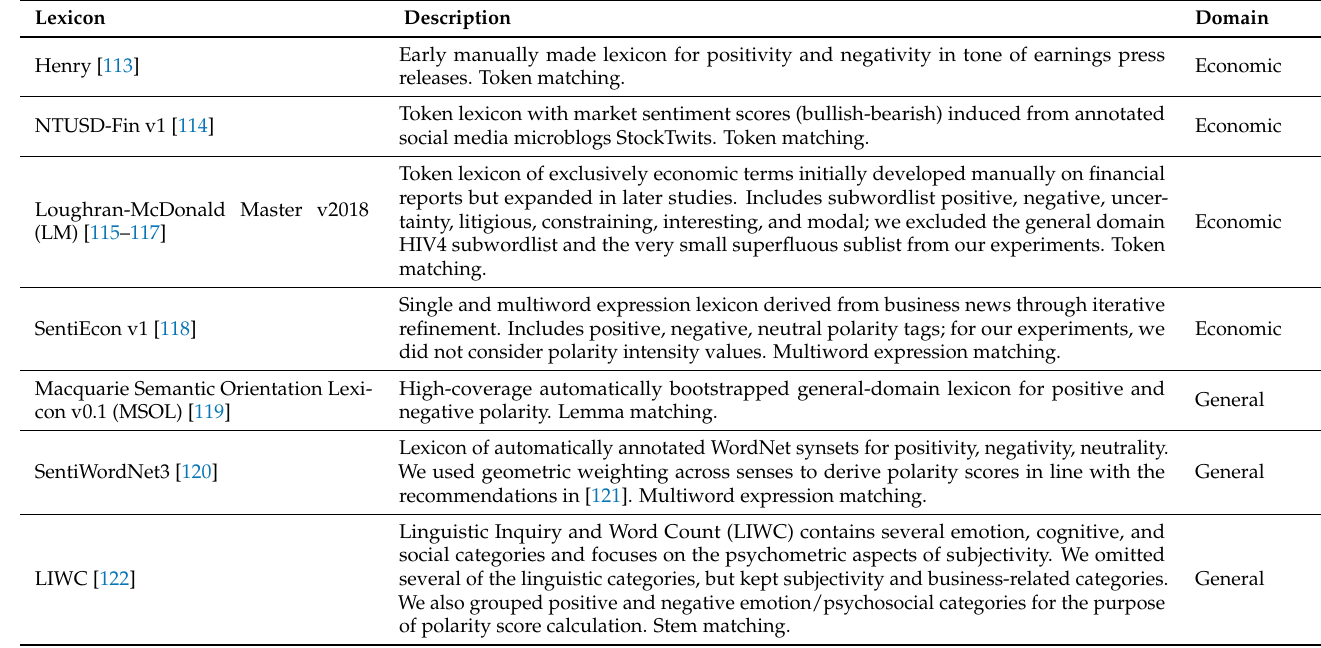
Table 4. Overview of subjectivity lexicons used in coarse-grained implicit sentiment